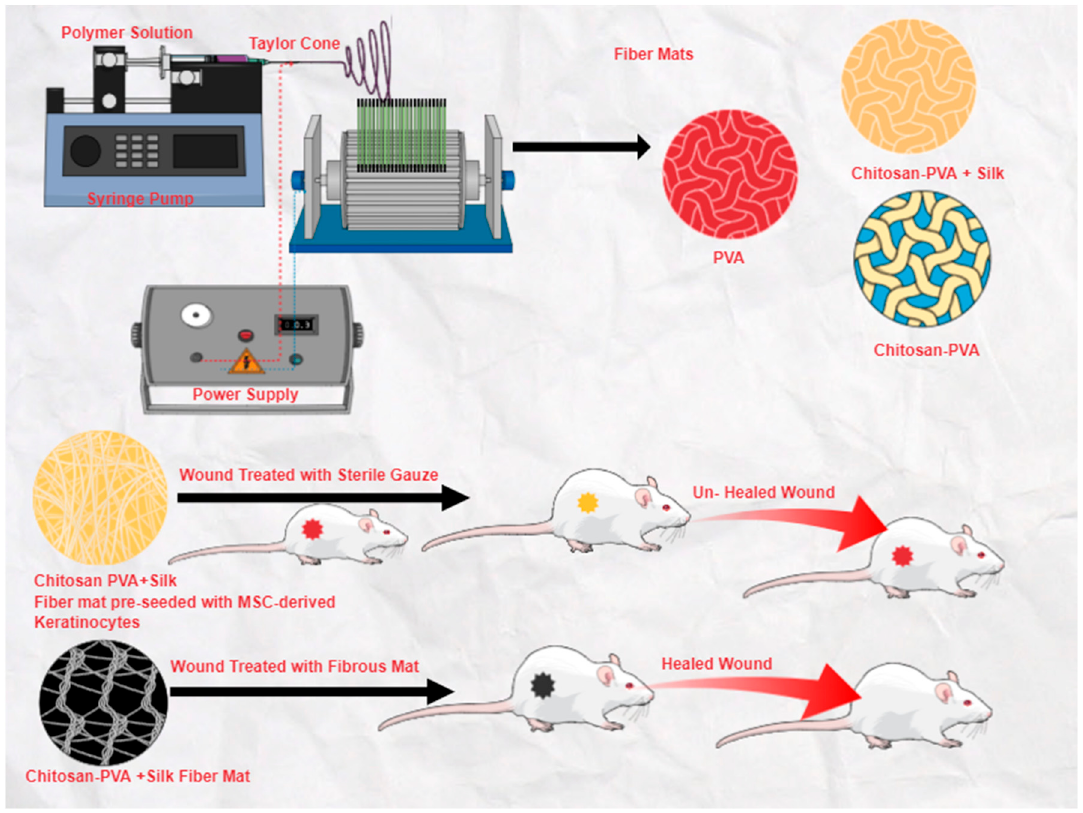
Figure 5. Electrospun Chitosan–PVA-Silk nanofibers mat for wound healing.